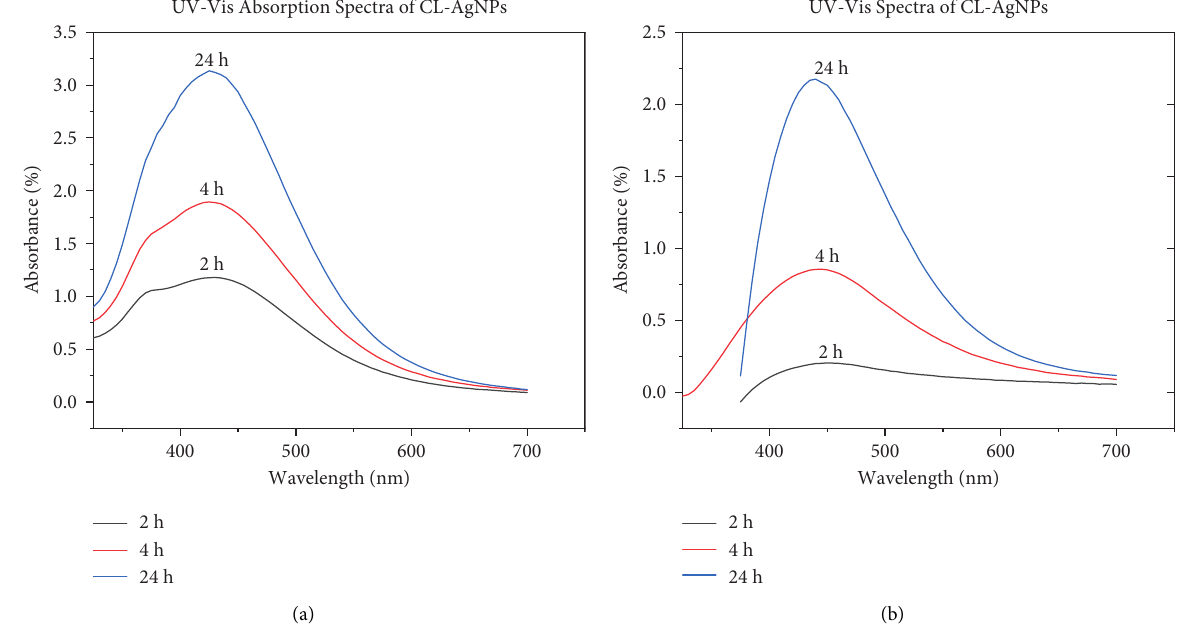
Figure 1: (a) UV-Vis absorption spectra of CL-AgNPs. (b) UV-vis absorption spectra of CP-AgNPs.